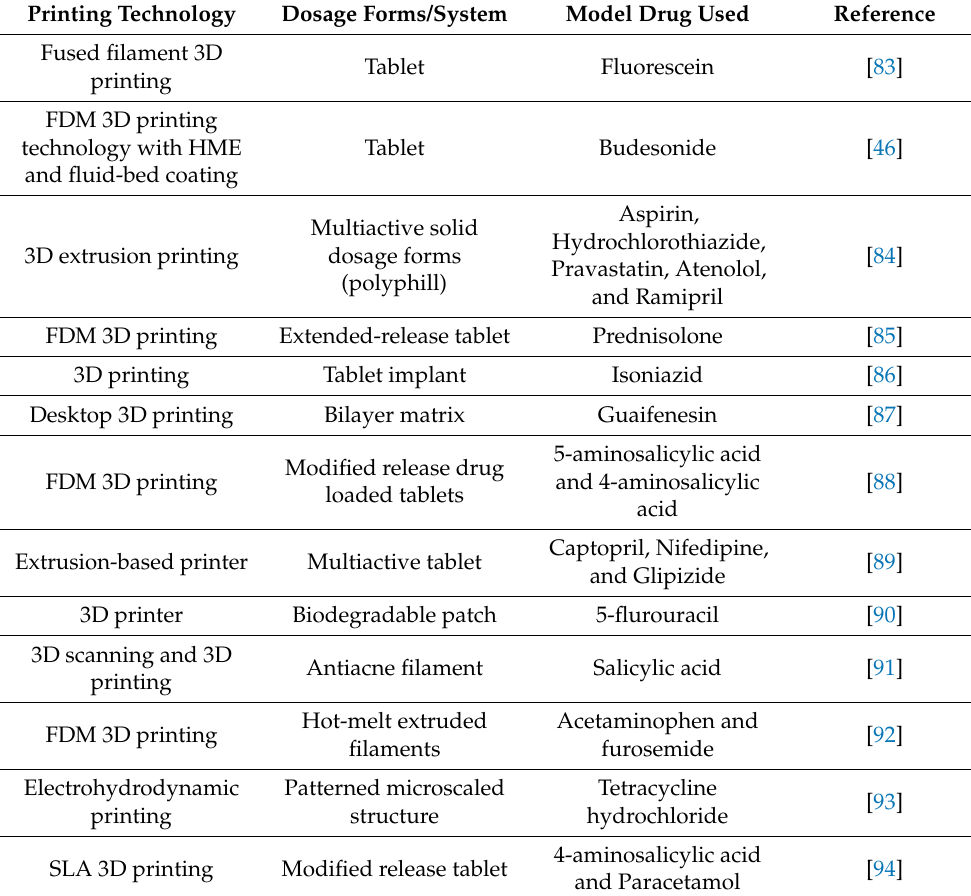
Table 3. Summary of 3D printing technologies being investigated for pharmaceutical formulation